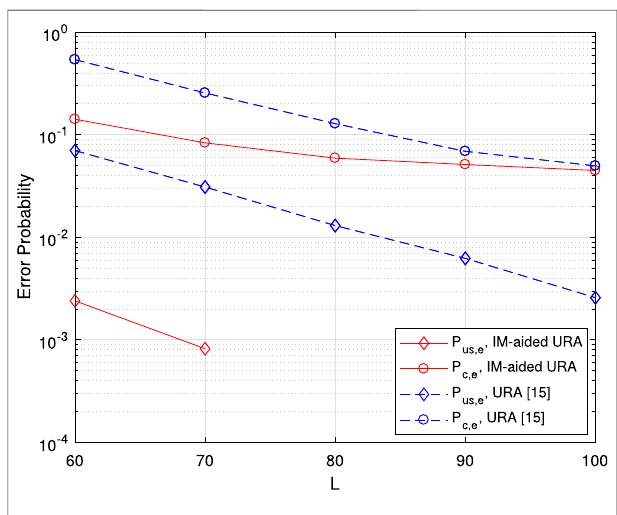
FIGURE 10 | Error probability vs. channel blocks length L. Here, the numbers of BS antennas and active users are M (cid:1) 200 and K a (cid:1) 200, respectively. For user-speci fi c information, misdetection and false alarm are not observed in both schemes.